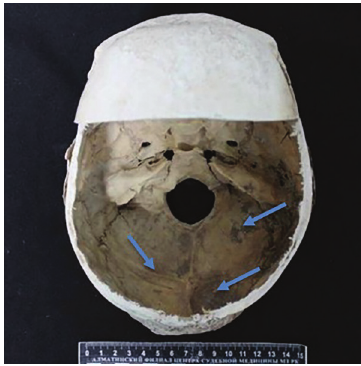
Figure 5 - View of the base of the skull from the inside (the arrow indicates the described